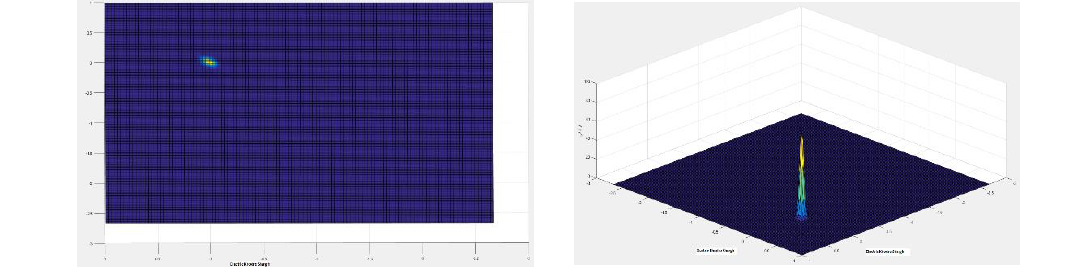
Figure 1.a. Vertical Plot For Presentation The PDF Of “Electric Khodro Shargh”